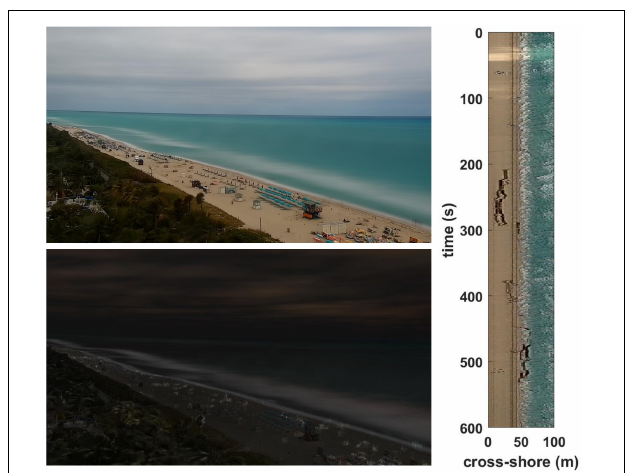
FIGURE 2 | An example time-exposure (top), time-variance (bottom) and time-stack (right) imagery from the Miami, FL webcam at 1200 UTC on March 10, 2018. Note the white pixels varying along the beach that indicate where waves are breaking in the time-exposure image.